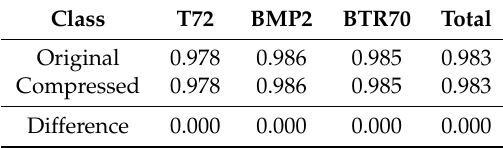
Table 5. 3-class recognition accuracy comparison of original network and compressed